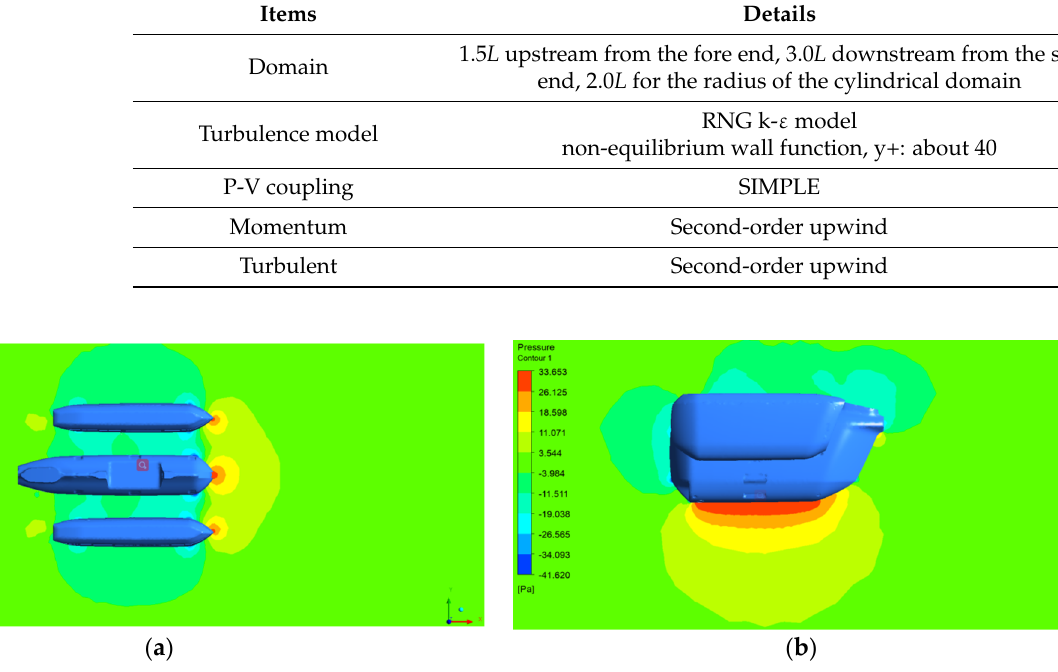
Figure 11. ( a ) Pressure contour in the forward direction ( v = 1.5 kn); ( b ) pressure contour in the descending direction ( v = 0.5 kn). Table 6. Thruster specification.